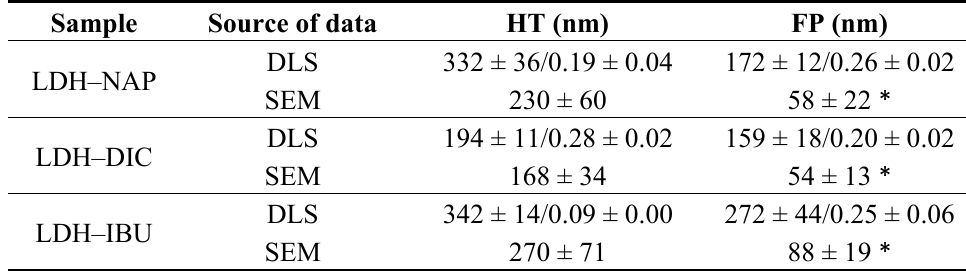
Table 1. Average particle size and polydispersity index (PDI) of layered double hydroxide (LDH) drug measured by dynamic light scattering (DLS) and average lateral diameter by scattering electron microscopy (SEM). Data are expressed as the mean ± SD